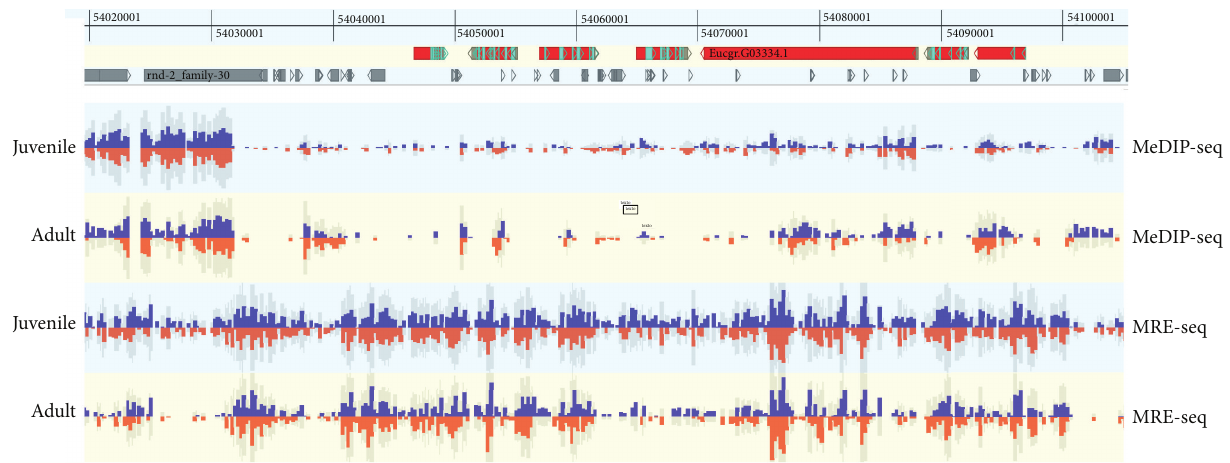
Figure 1: Epigenome view (GenomeView software) of a 138.7 kb region of chromosome 07 (54,020,001–54,100,001) of Eucalyptus grandis reference genome. MeDIP-seq libraries and MRE-seq libraries covered largely nonoverlapping and short overlapping